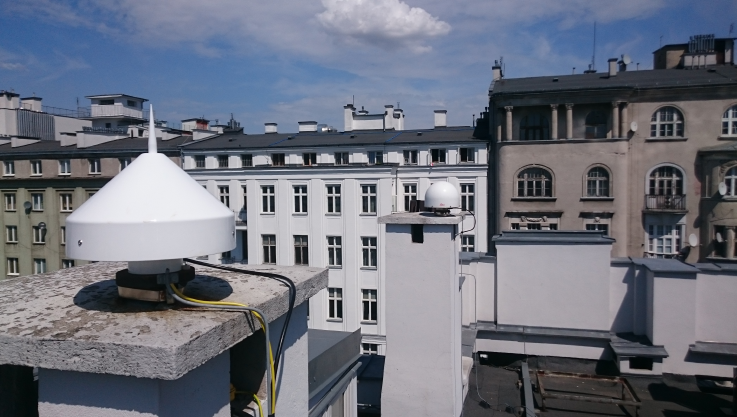
Figure 1. Environment at the WUT antennas site (in the foreground is WUT2 station).